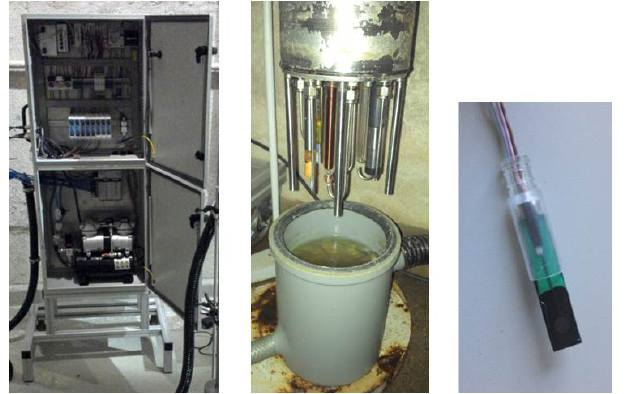
Figure 1. Left: control cabinet of the measuring system for moni- toring process water; middle: multi-sensor probe with different elec- trodes and compressed air jets and the measuring vessel; right: re- dox glass